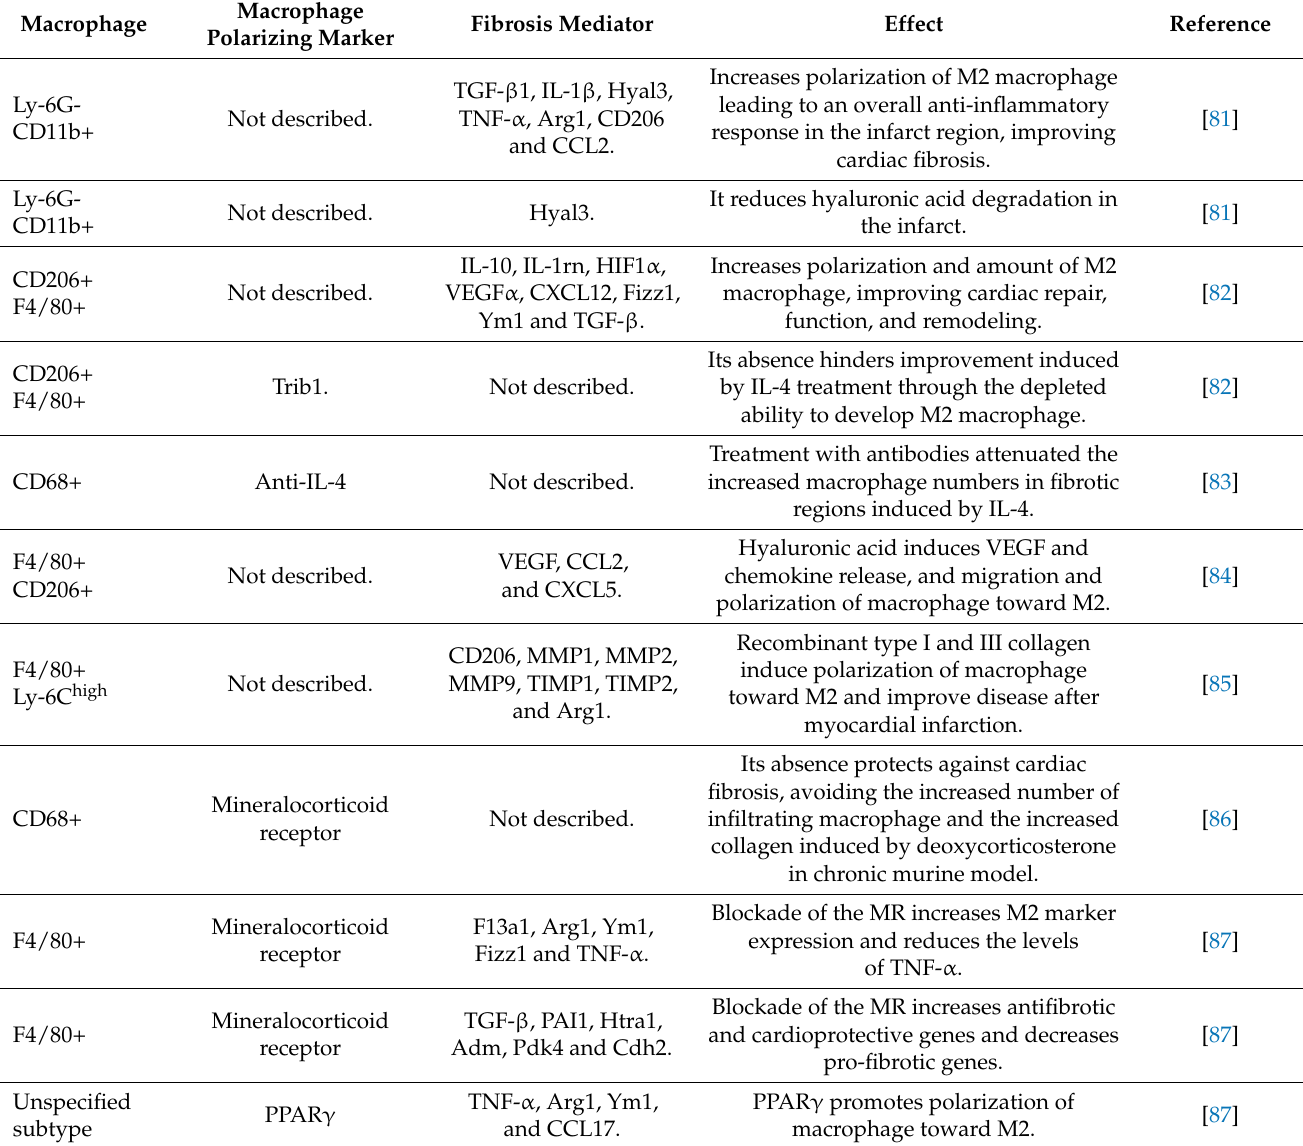
M2 macrophage due to the inactivity of MR decreases cardiovascular inflammation and fibrosis [86,87]. Table 2. Table summarizing how and which types of macrophages are involved in cardiac fibrosis. Lymphocyte antigen 6 complex, locus C1 (Ly6C), Cluster of differentiation (CD), Transforming Growth Factor-beta (TGF- β ), Interleukin (IL), Tumor necrosis factor-alpha (TNF- α ), Arginase 1 (Arg1), Mannose receptor 1 (CD206), Mannose receptor 2 (Mrc-2), Chemokine C-C motif ligand (CCL), Macrophage anti-inflammatory/pro-fibrotic (M2), Hypoxia induced factor 1 alpha (HIF α ),